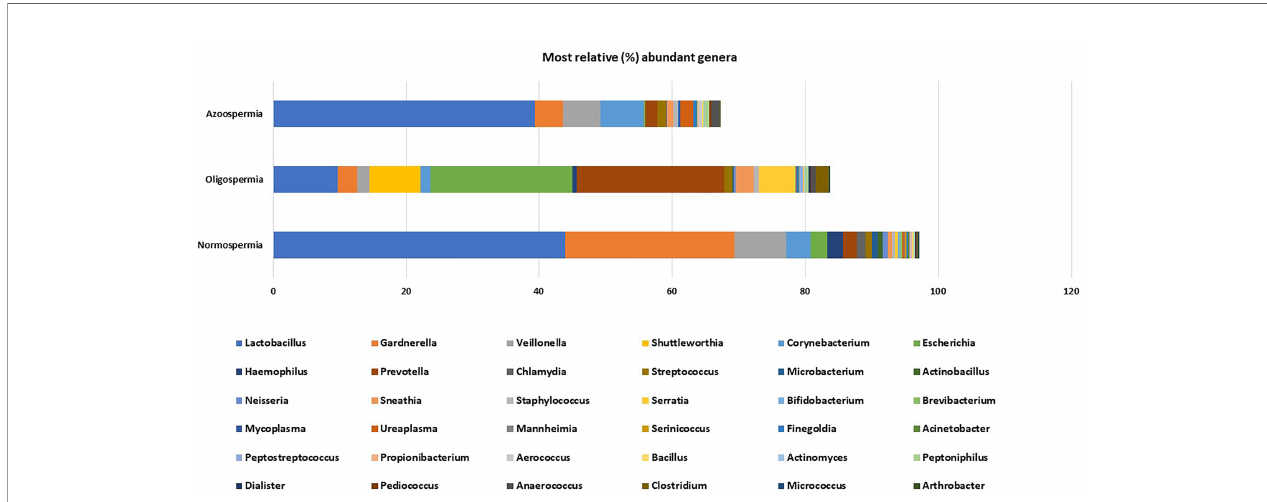
FIGURE 3 | Most relative (%) genera abundance between the semen categories.